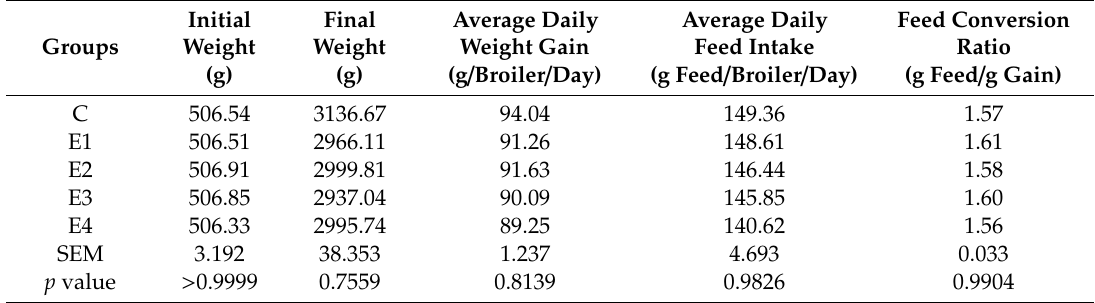
Table 2. Production parameters throughout the experimental period (14–42